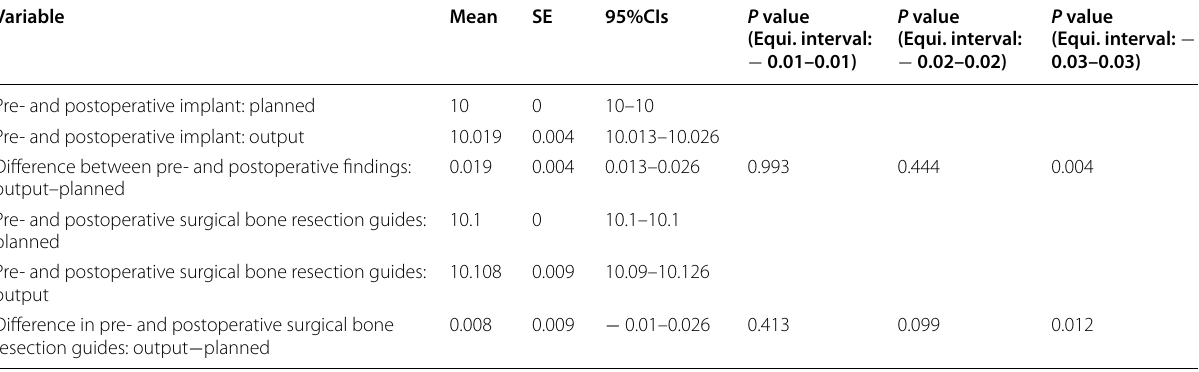
Table 2 Accuracy of printed implants and surgical bone resection guides: equivalence comparison Variable